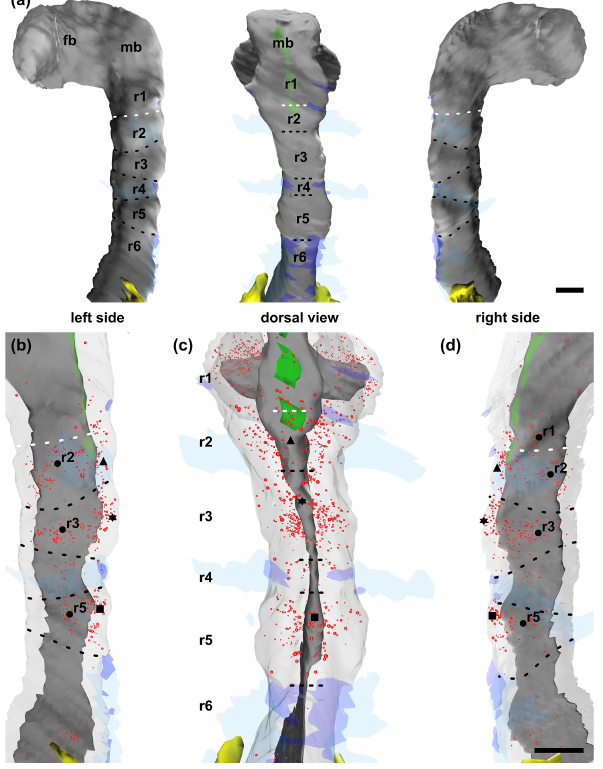
Figure 18. Segment-specific patterns of cell death and neural crest delamination in the developing hindbrain of Tupaia belangeri . 13- somite embryo. 3-D reconstructions demonstrate the pial ( a : dark gray; b–d : light gray) or the ventricular surface ( b–d : dark gray) of the brain (fb, forebrain; mb, midbrain; r1–r6, rhombomeres 1–6), delaminating (blue) and migrating (light blue) neural crest cells, ventricular protrusions of the fusing neural folds (green), the first somite (yellow), and individually marked apoptotic cells (red). (a) Definitive (black dotted lines) and less distinct (white dotted lines) interrhombomeric boundaries stand out at the pial surface of the hindbrain. (b–d) : left (b) , dorsal (c) , and right (d) views of apop- totic patterns within the hindbrain walls. Apoptotic maxima exist in dorsal parts of r3 (asterisks); r5 (rectangles); and, to a lesser ex- tent, r2 (triangle). Note transverse apoptotic bands in r3 and r5 and curved apoptotic bands in r1/2 (black dots). Scale bars = 100µm. Reproduced from Knabe et al. (2004b, Fig. 4). © Springer-Verlag 2004, with kind permission from Springer Science and Business Media.